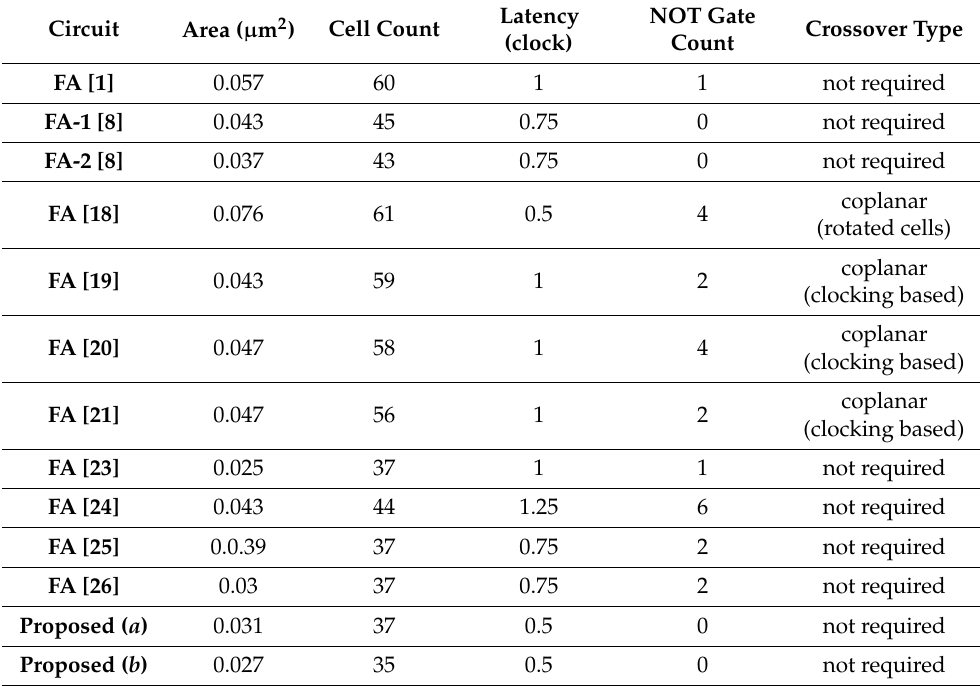
Table 2. Comparison analysis of the novel FA circuits in comparison with